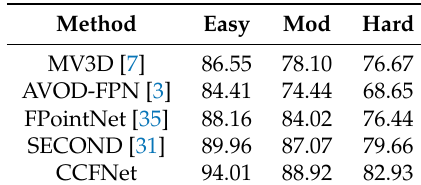
Table 5. Performance comparison with the compared methods on BEV car detection (AP, %) on the KITTI validation set.